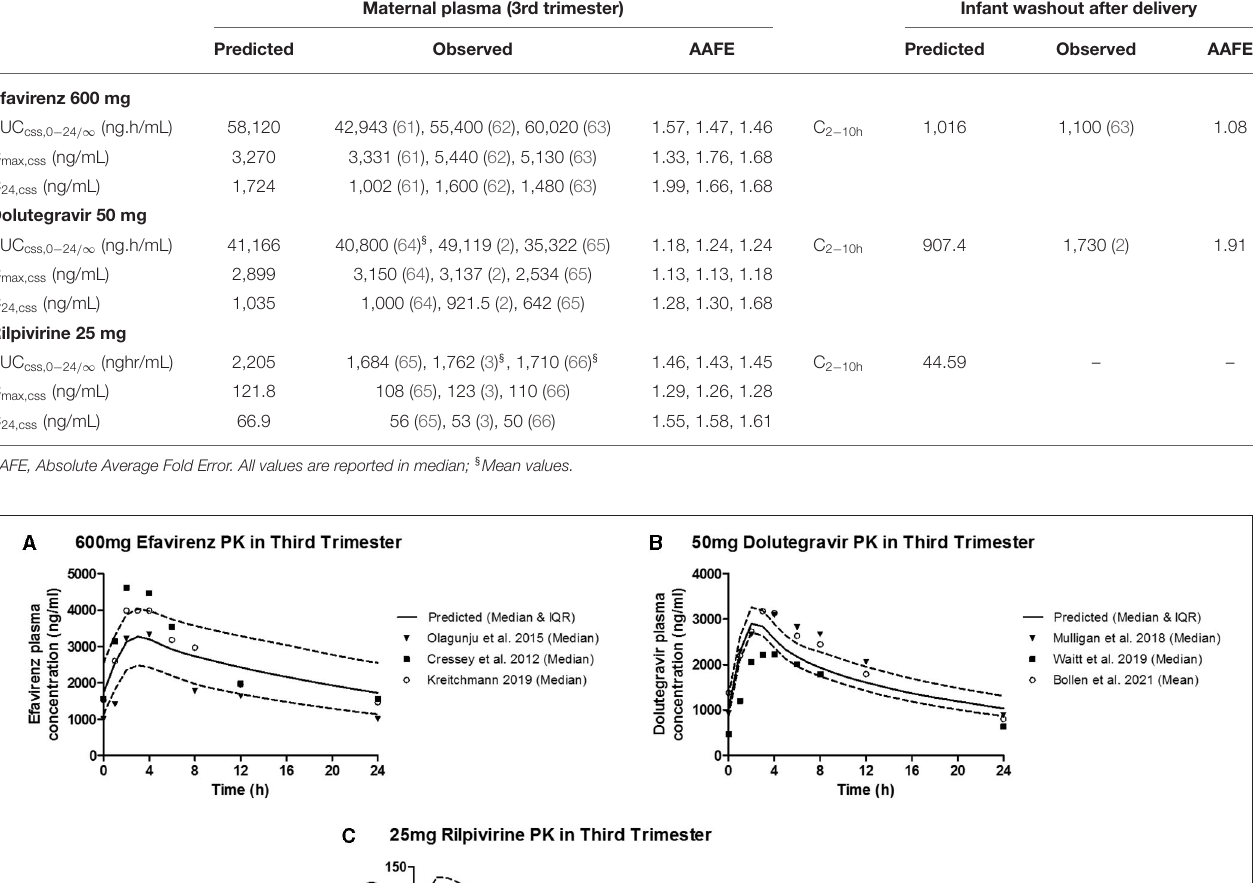
TABLE 4 | Pharmacokinetic parameters of efavirenz, dolutegravir, and rilpivirine in third trimester of pregnancy and infant washout after delivery. Maternal plasma (3rd trimester) Infant washout after delivery Predicted Observed AAFE Predicted Observed AAFE